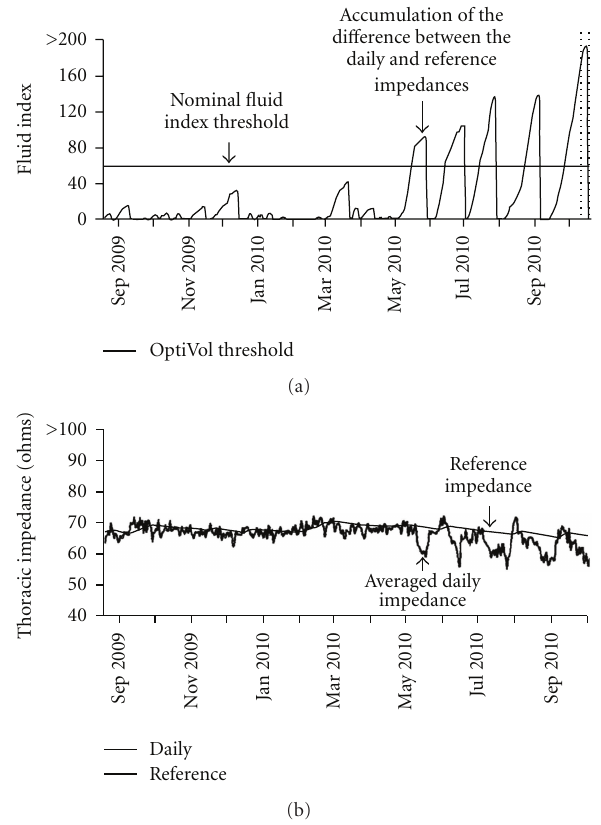
Figure 1: OptiVol fluid index. The intrathoracic impedance is measured on a daily basis and is compared to the patient’s “reference” value, which is derived from the average of the last 4 daily measurements. Negative deviations from the reference value suggest a decrease in intrathoracic impedance, which may reflect pulmonary congestion. The di ff erence between the measured intrathoracic impedance and the reference value is multiplied by time (measured in days) to generate the OptiVol fluid index, which has a unit measurement of ohms · days. The magnitude of the fluid index value is determined by (i) the absolute di ff erence between the reference value and the measured intrathoracic impedance, and/or (ii) the time duration of the di ff erence. The fluid index is plotted against time to graphically display the onset and duration of negative deviations of intrathoracic impedance. The nominal cut- o ff threshold is set as 60 ohms ·